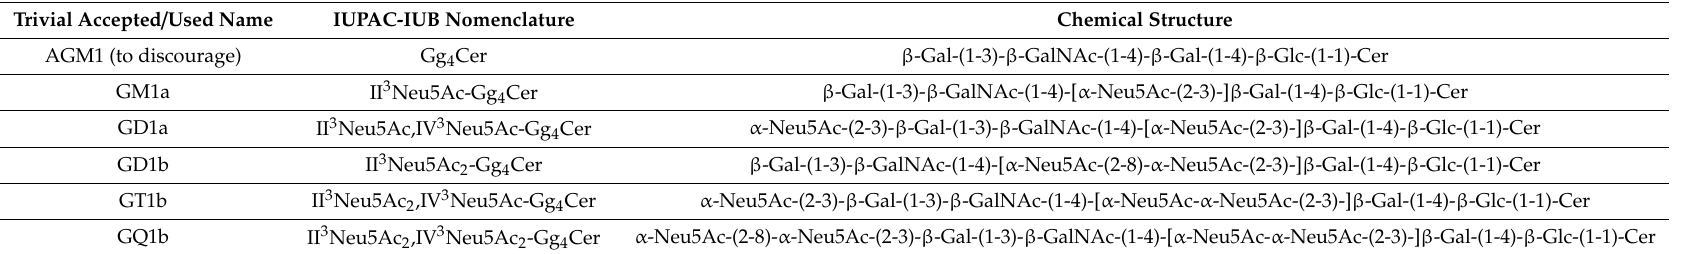
Table 1. Structure of the main brain gangliosides belonging to the ganglioside series